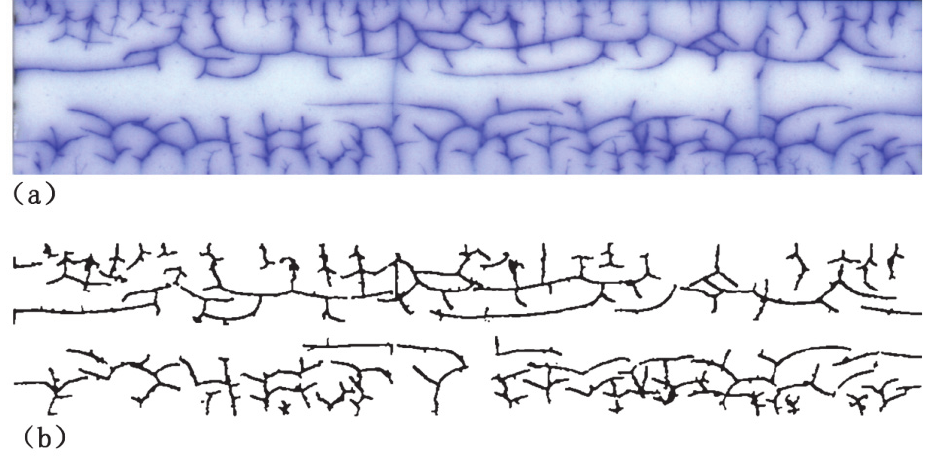
Figure 3. Comparison between the original image and processed image of cracks. ( a ) Original image of cracks. ( b ) Processed image of cracks.